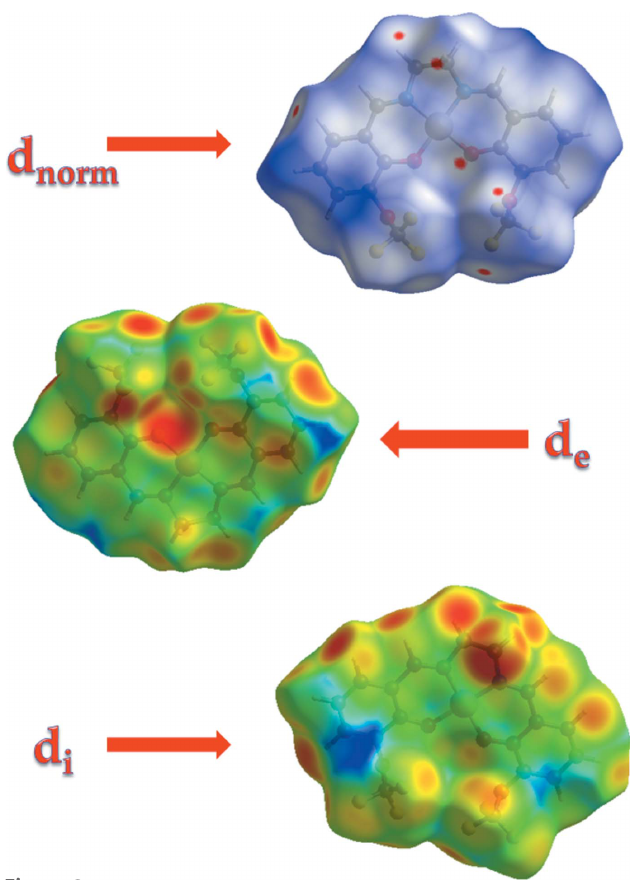
Figure 3 The Hirshfeld surface mapped over d norm , d i and d e